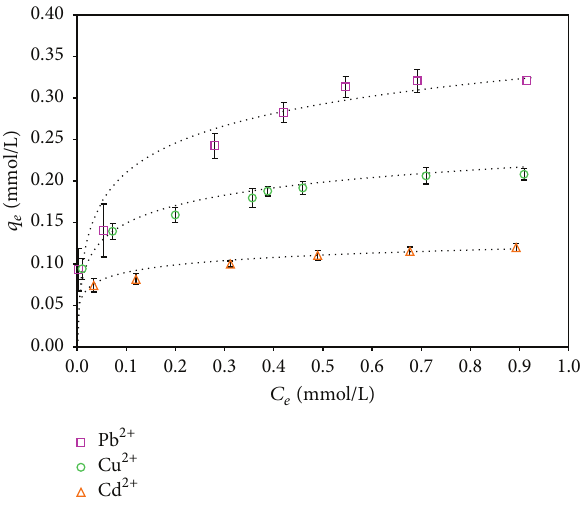
Figure 1: Isotherm adsorption of Cd 2+ , Cu 2+ , and Pb 2+ onto SCG. Experimental conditions: 1 g SCG/L, pH 4.5, and 25 ∘ C. Solid lines represent the ion-exchange multicomponent model. Error bars represent standard deviation of triplicate measurements. Table 1: Maximum adsorption capacities of heavy metals onto various adsorbents reported in